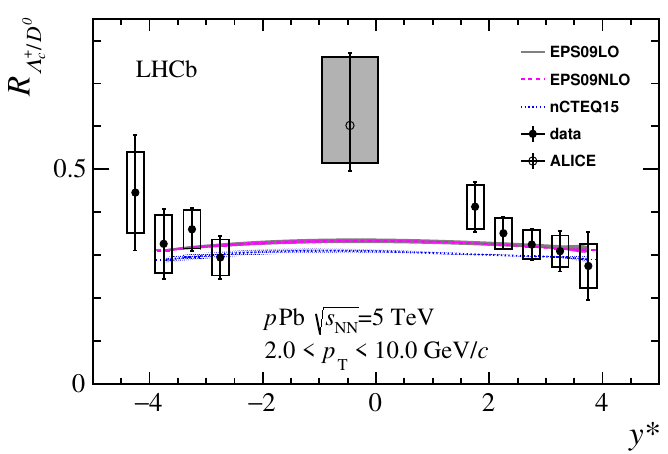
Figure 7 . The cross-section ratio R between (cid:3) + baryons and D 0 mesons as a function of y (cid:3) c (cid:3) + c =D 0 integrated over 2 < p T < 10 GeV =c . The box on each point represents the systematic uncertainty and the error bar represents the sum in quadrature of the statistical and the systematic uncertainties. The coloured curves show HELAC-Onia calculations incorporating nPDFs EPS09LO/NLO and nCTEQ15. The open circle is the value measured by the ALICE collaboration [21]. The error bar shows the total uncertainty and the grey square the